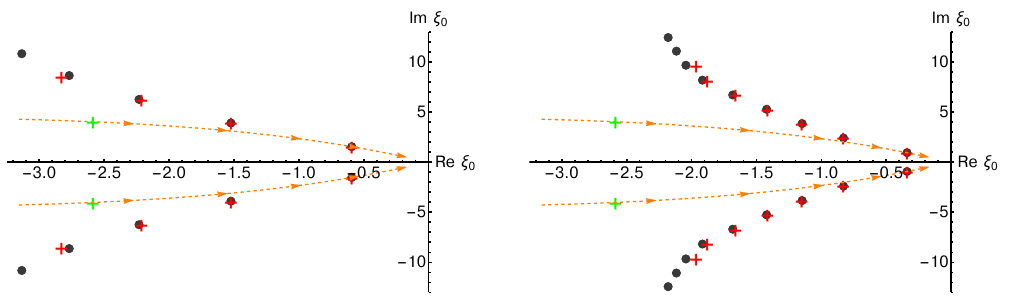
Figure 9 . QNMs and leading singularities on the Borel plane for the ∆ = 2 RG flow with β 2 = 3 (or λ GB = 6) (left panel) and β 2 = 5 (or λ GB = − in the expansion (4.12). See text for the legend.